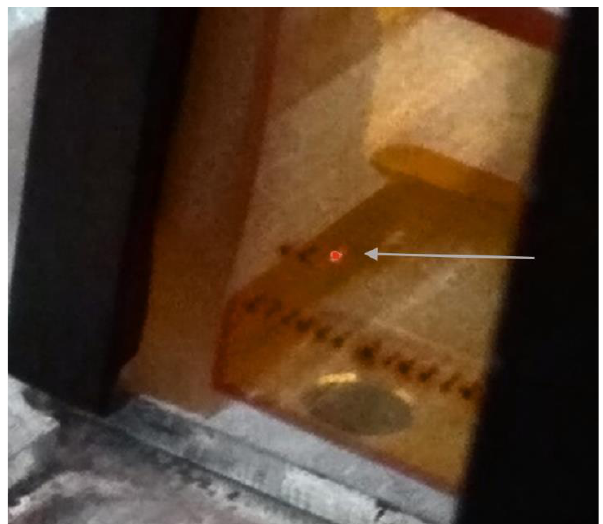
Figure 7. The red glow from the laser-irradiated area of the ZnSe sample.